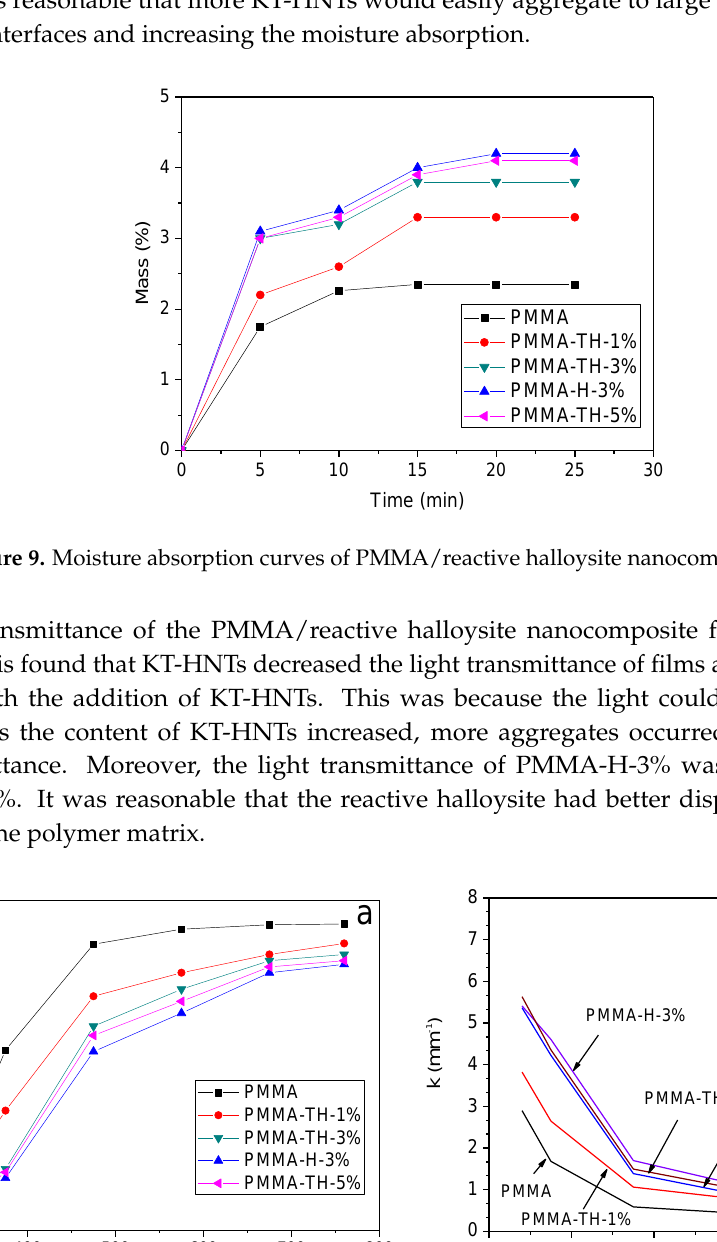
Figure 8. DSC curves of PMMA and PMMA/reactive halloysite nanocomposite.